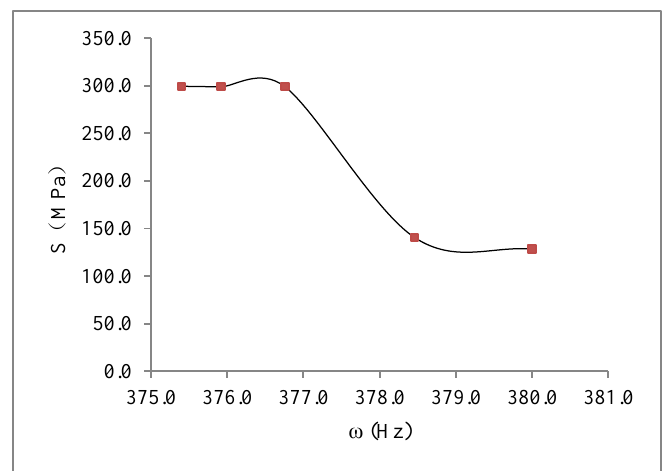
Figure 8. Vibration frequency – stress of aluminium alloy 7050.